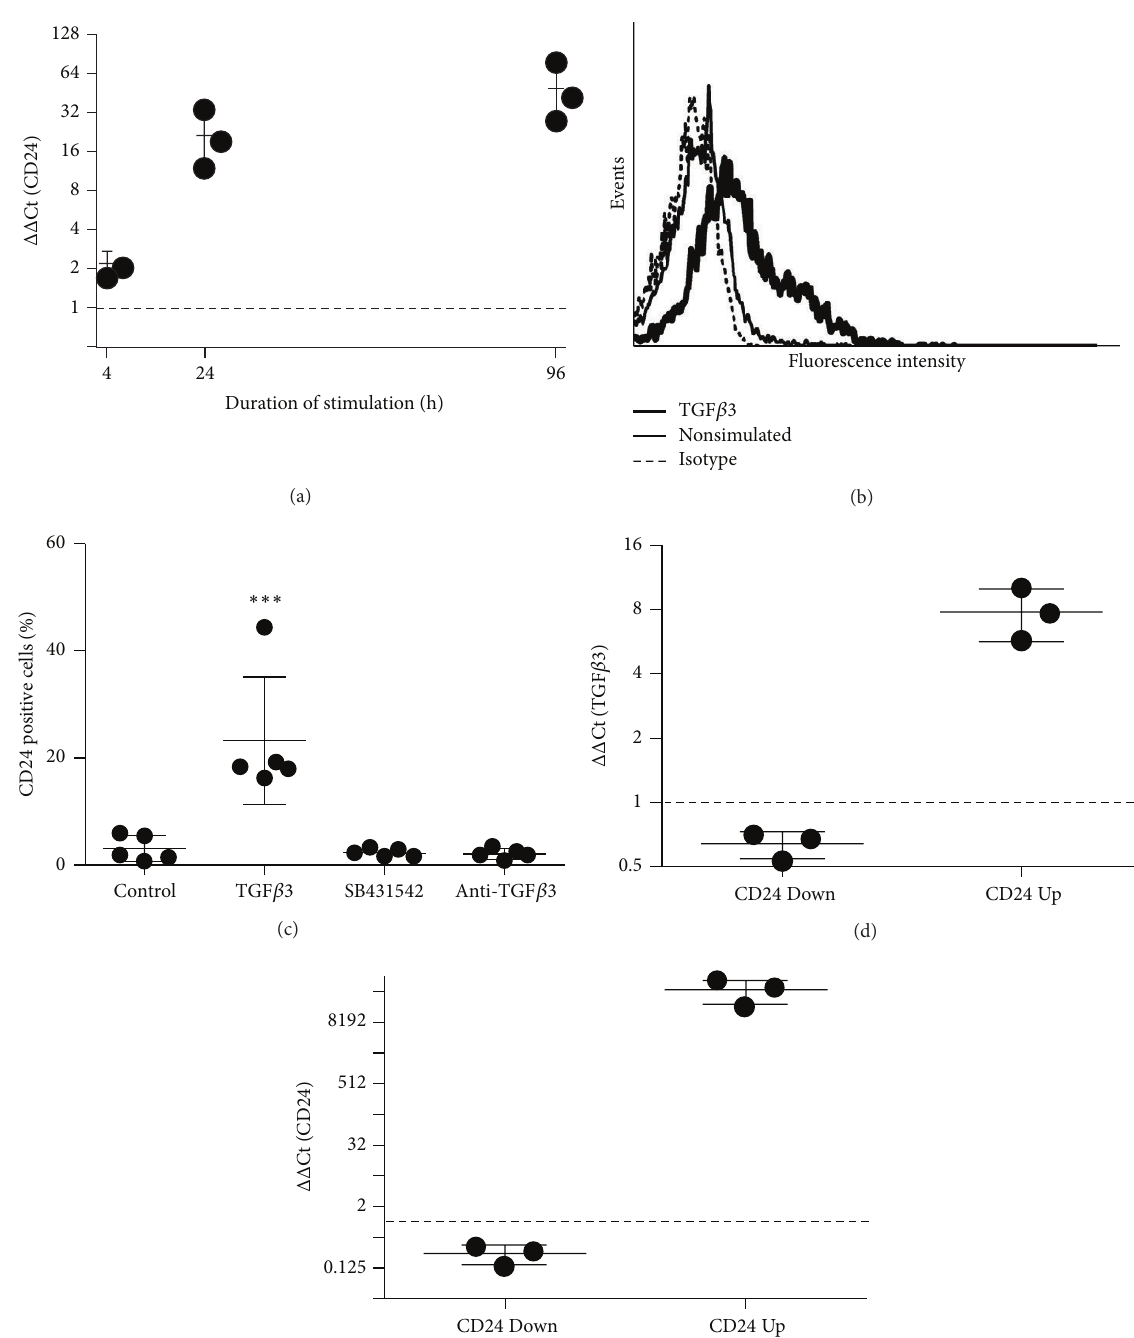
Figure 3: Reciprocal regulation of CD24 and TGF 𝛽 3. (a) qRT-PCR analysis of CD24 mRNA expression after stimulation with 10ng/mL TGF 𝛽 3 for 4h, 24 h, and 96h relative to unstimulated control cells ( ΔΔ Ct). (b) Exemplary histogram showing induction of CD24 surface expression after treatment with 10 ng/mL TGF 𝛽 3 or with 2.5 ng/mL TGF 𝛽 1 for 7 days as analyzed by flow cytometry. (c) Flow cytometric analysis of CD24 surface protein expression on hBMSCs after 7 days in unstimulated control cells (Control), in cells treated with 10ng/mL TGF 𝛽 3 (TGF 𝛽 3), in cells treated with 10 ng/mL TGF 𝛽 3 + 20 𝜇 M SB431542 (SB431542), or in cells treated with 10 ng/mL TGF 𝛽 3 and 4 𝜇 g/mL anti-TGF 𝛽 3 antibody (anti-TGF 𝛽 3). (d) and (e) qRT-PCR analysis of TGF 𝛽 3 (d) and CD24 (e) mRNA expression after knockdown (CD24 Down) or overexpression (CD24 Up) of CD24 in hBMSCs after 7 days relative to respective control hBMSCs ( 𝑛 = 3 independent experiments with hBMSCs from different